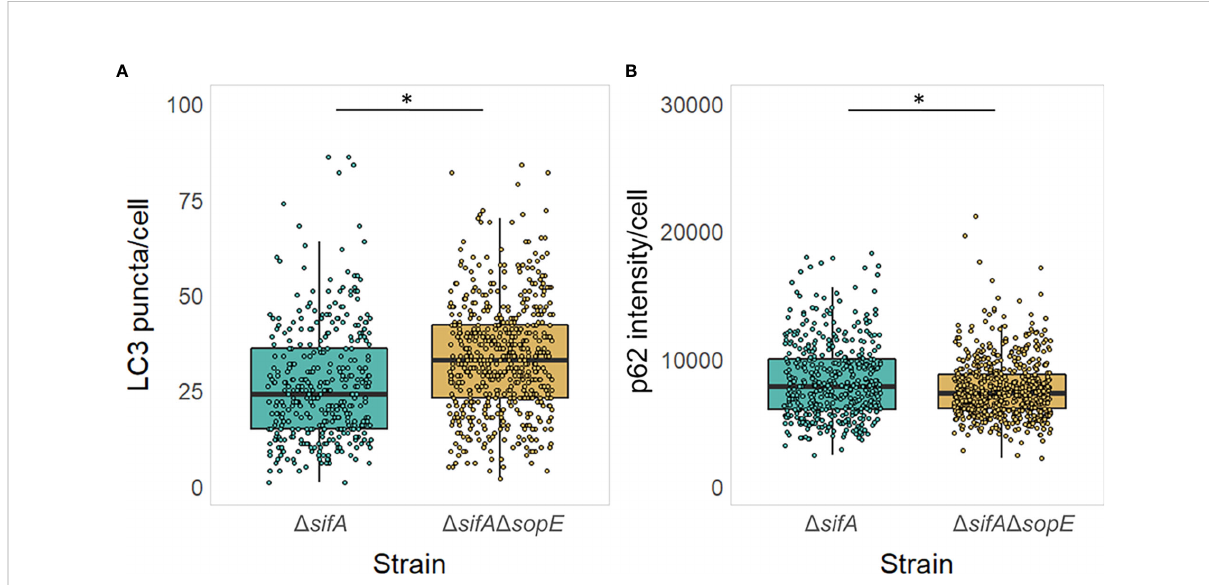
FIGURE 5 Cytosolic Salmonella no longer can dampen the autophagy fl ux in a SopE-dependent manner. (A, B) Autophagy was pre-induced with Rapamycin in HT-29 epithelial cell monolayers and maintained during the 6h infection with Salmonella , as it exacerbates the impact of SopE on modulating autophagy, making it easier to visualise. LC3 puncta (A) and p62 intensity (B) was quanti fi ed from HT-29 cells containing Salmonella .